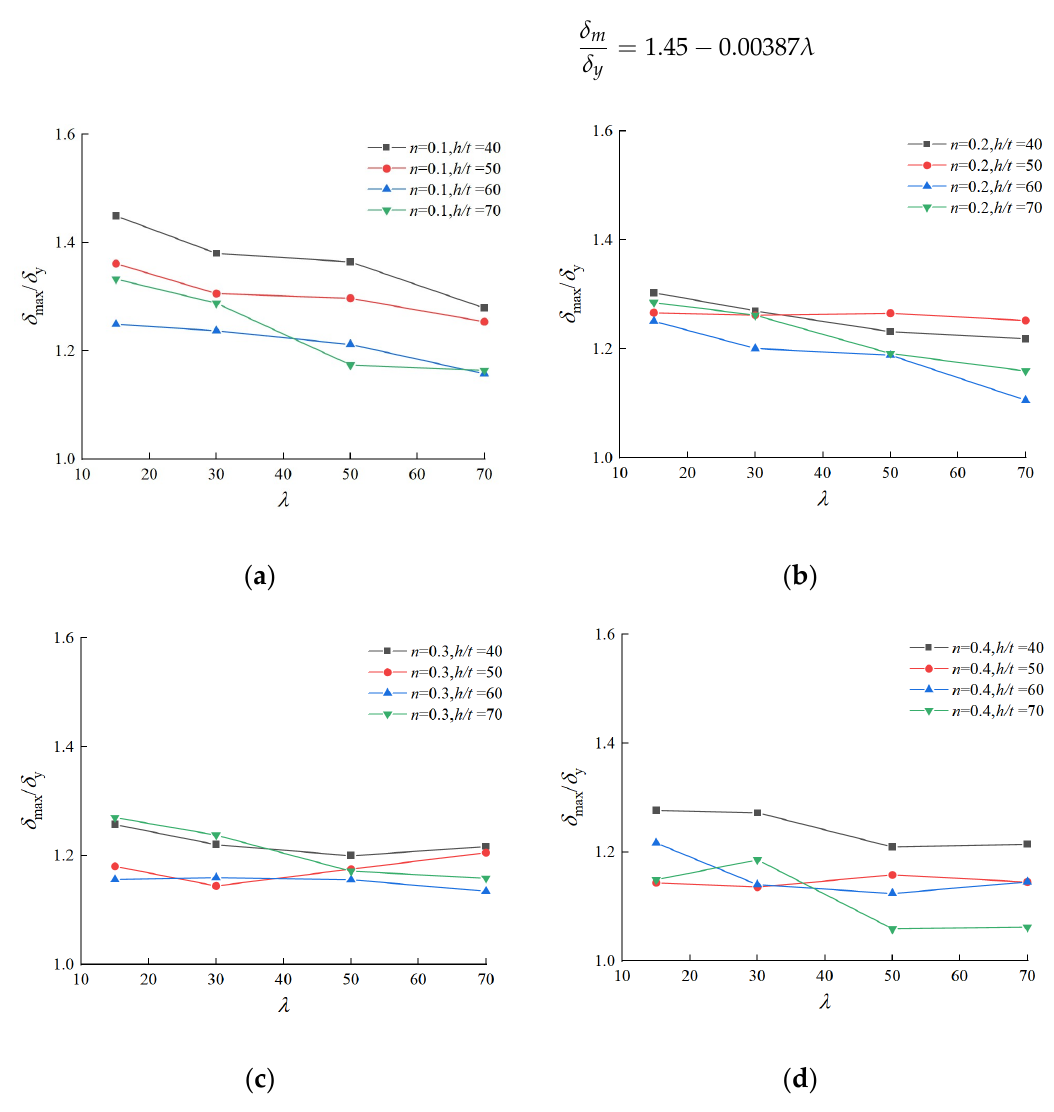
Figure 21. The effect of λ on δ m / δ y . ( a ) n = 0.1; ( b ) n = 0.2; ( c ) n = 0.3; ( d ) n = 0.4.